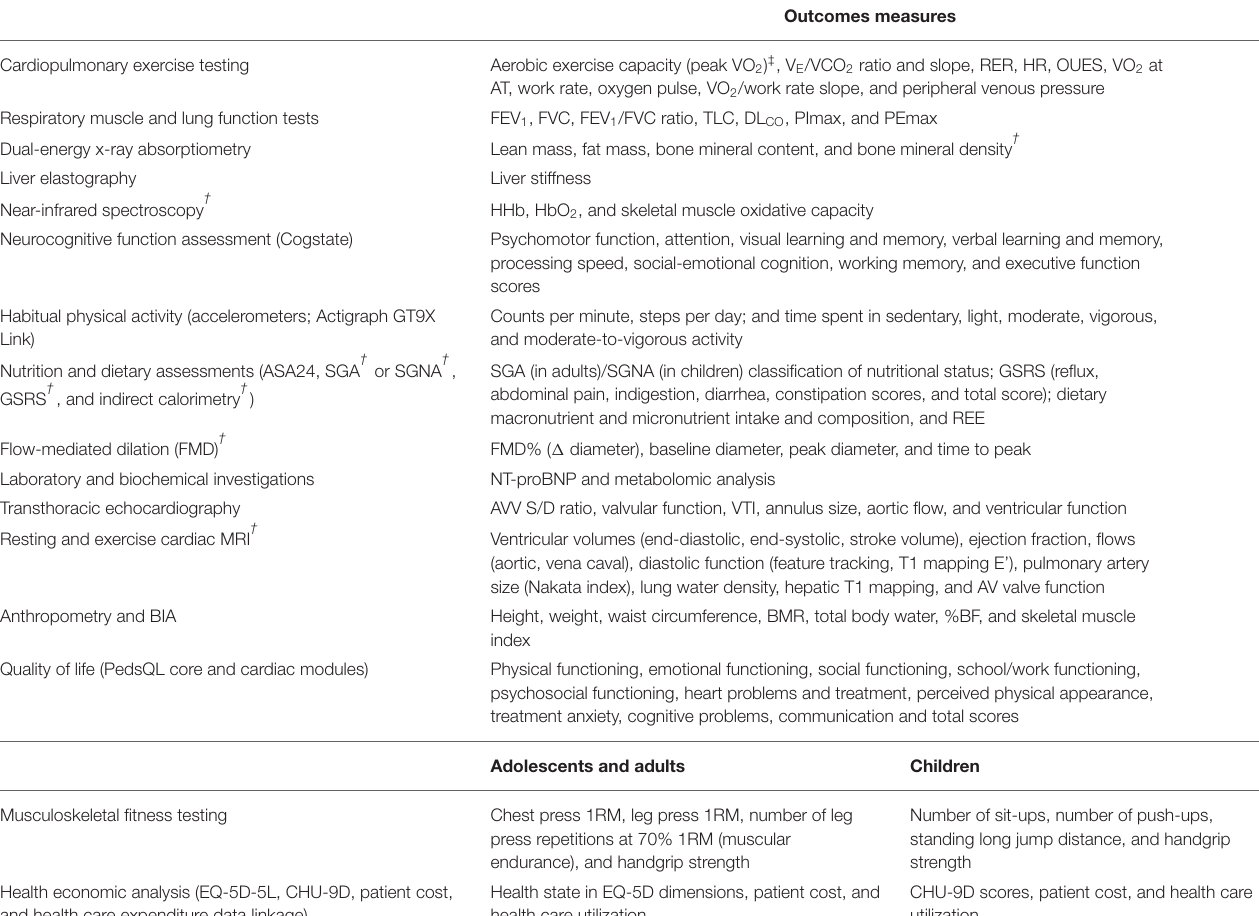
TABLE 2 | Assessments and testing.